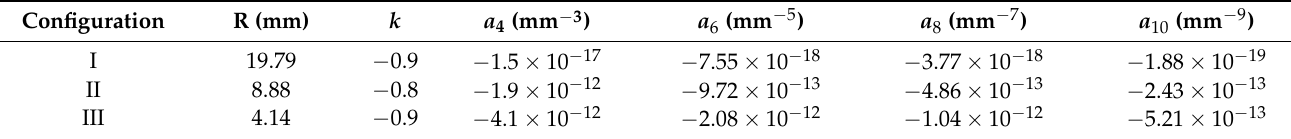
Table 1. Nominal values of the aspheric shapes parameters.